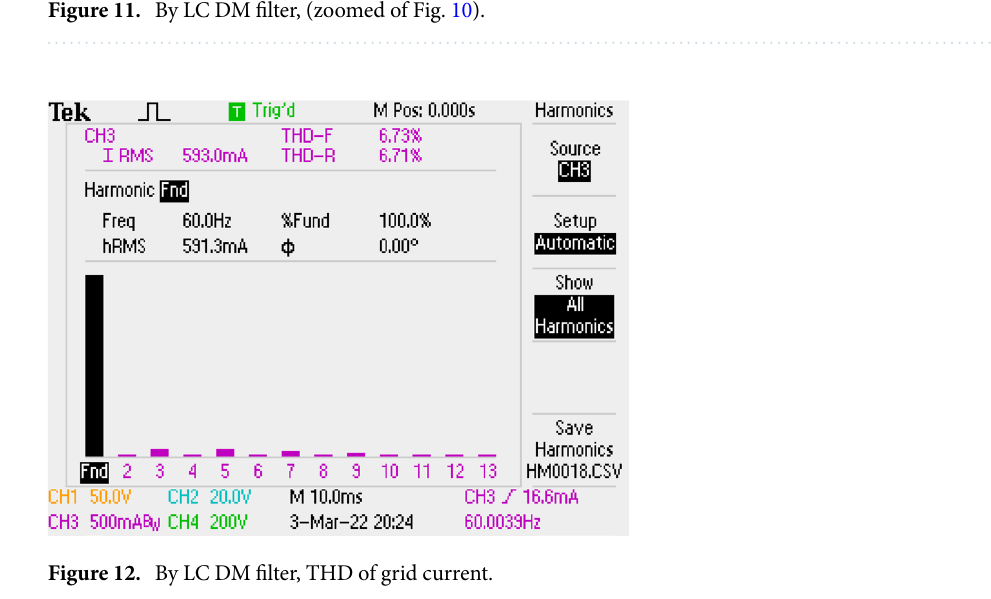
Figure 11. By LC DM filter, (zoomed of Fig. 10).